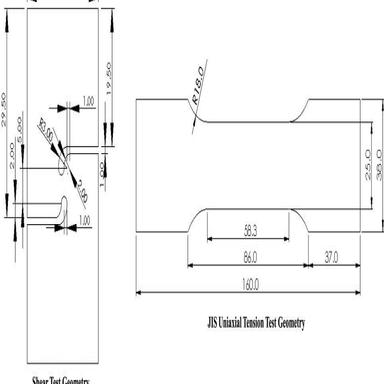
JIS No.5 uniaxial tension specimen geometry (left) and the shear test geometry (right) for constitutive characterization. All dimensions are in millimeters.